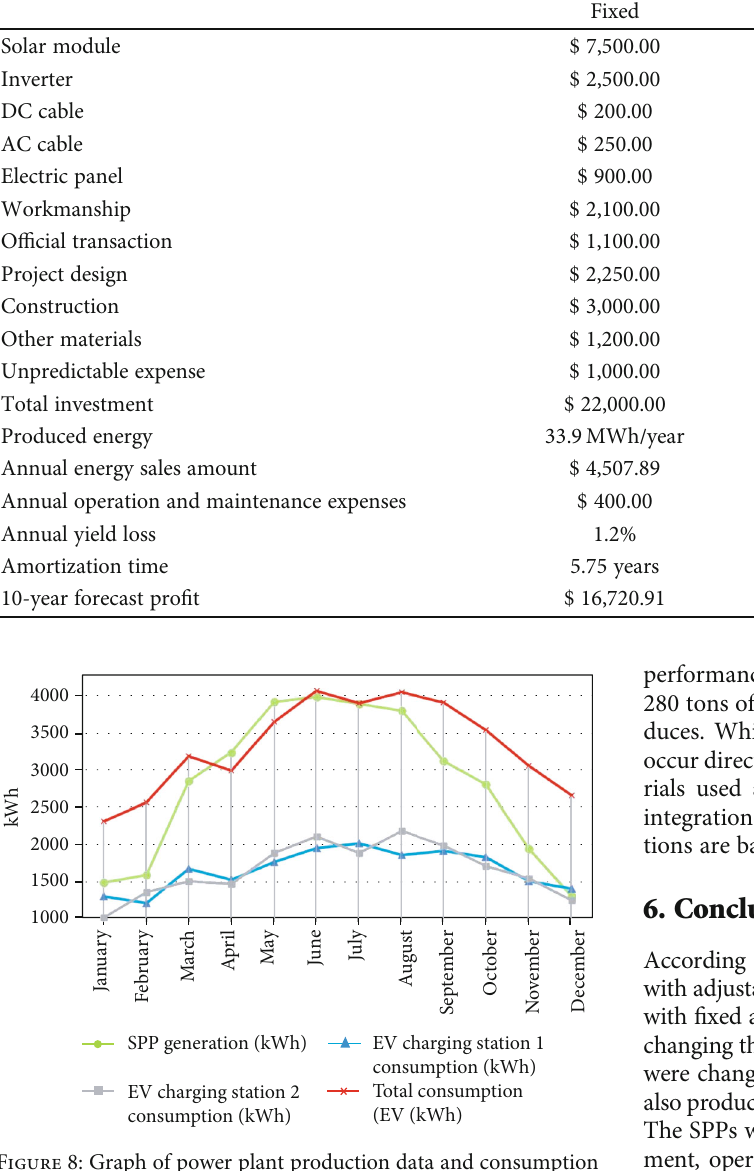
Figure 8: Graph of power plant production data and consumption of EV charging stations connected to this power